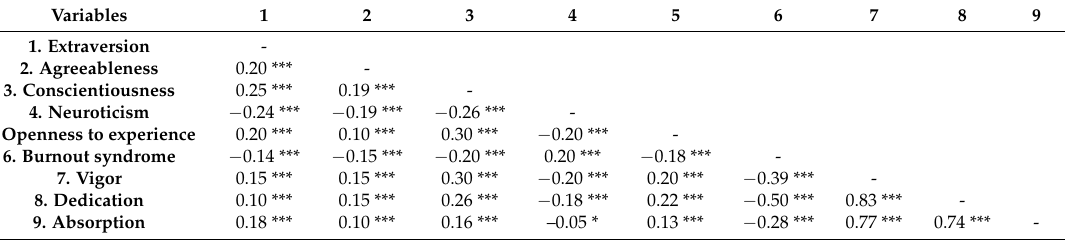
Table 1. Personality, burnout and engagement. Bivariate correlations.